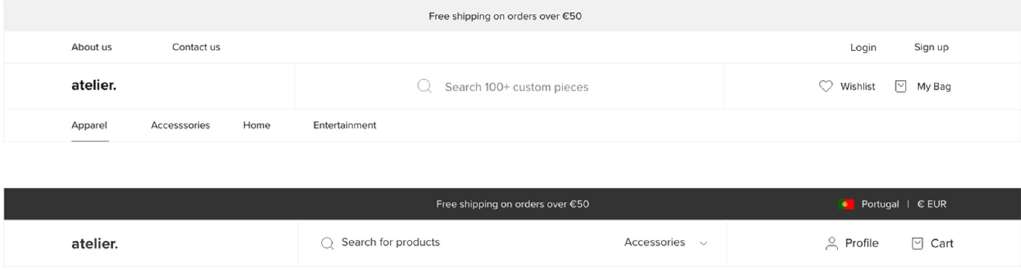
Figure 6. First A / B testing. Self-source, Figure 6. First A/B testing. Self-source, 2020.